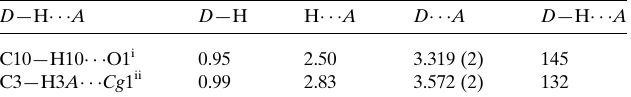
Table 4 Hydrogen-bond geometry (A˚ , (cid:2) ) for (IV).